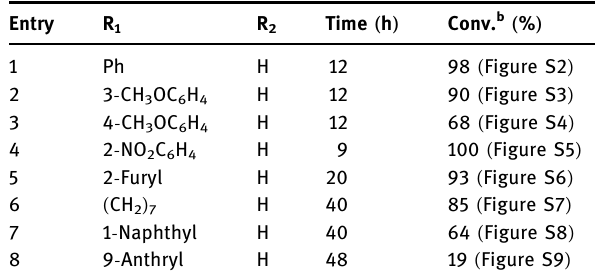
Table 3: The cyanation of TMSCN a with di ff erent carbonyl compounds